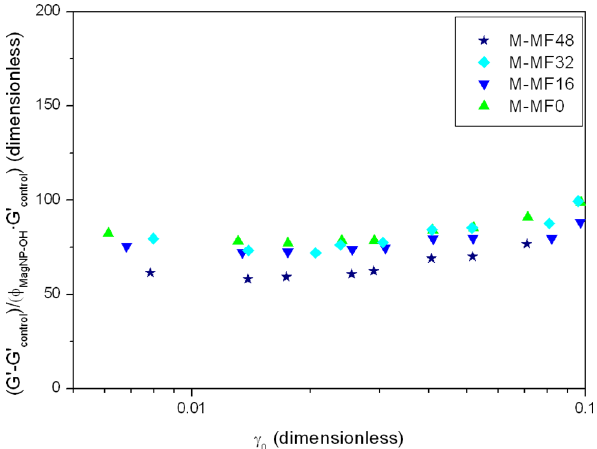
Fig 6. Normalized elastic modulus of magnetic tissue substitutes plotted as a function of shear strain amplitude. The elastic modulus, G 0 , of different magnetic tissue substitutes was normalized to account for the increase with respect to the elastic modulus of control (nonmagnetic) tissue substitutes without particles (Ctrl- MF0 to Ctrl-MF48), G 0 control , per unit volume concentration of magnetic particles, ϕ MagP − OH . Experimental groups: M-MF0: magnetic tissue substitute gelled in the absence of a magnetic field; M-MF16, M-MF32 and M-MF48: magnetic tissue substitutes gelled during application of a 16 kA m -1 , 32 kA m -1 or 48 kA m -1 field, respectively.